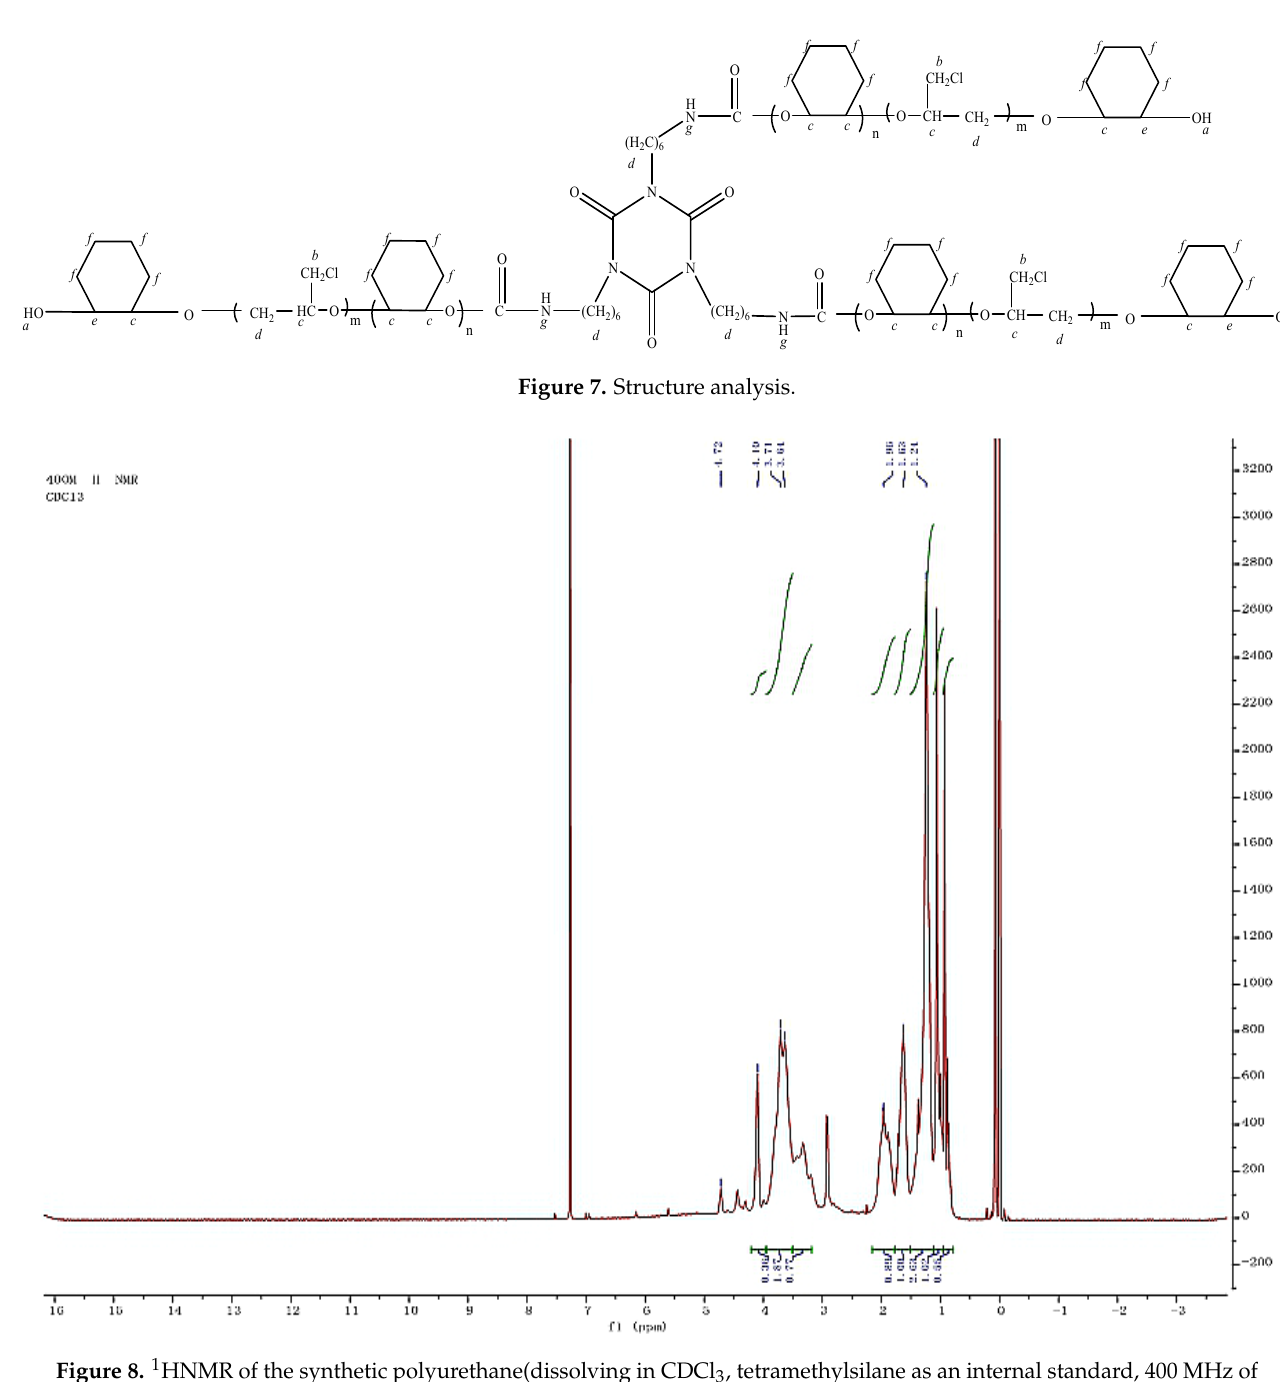
Figure 7. Structure analysis.